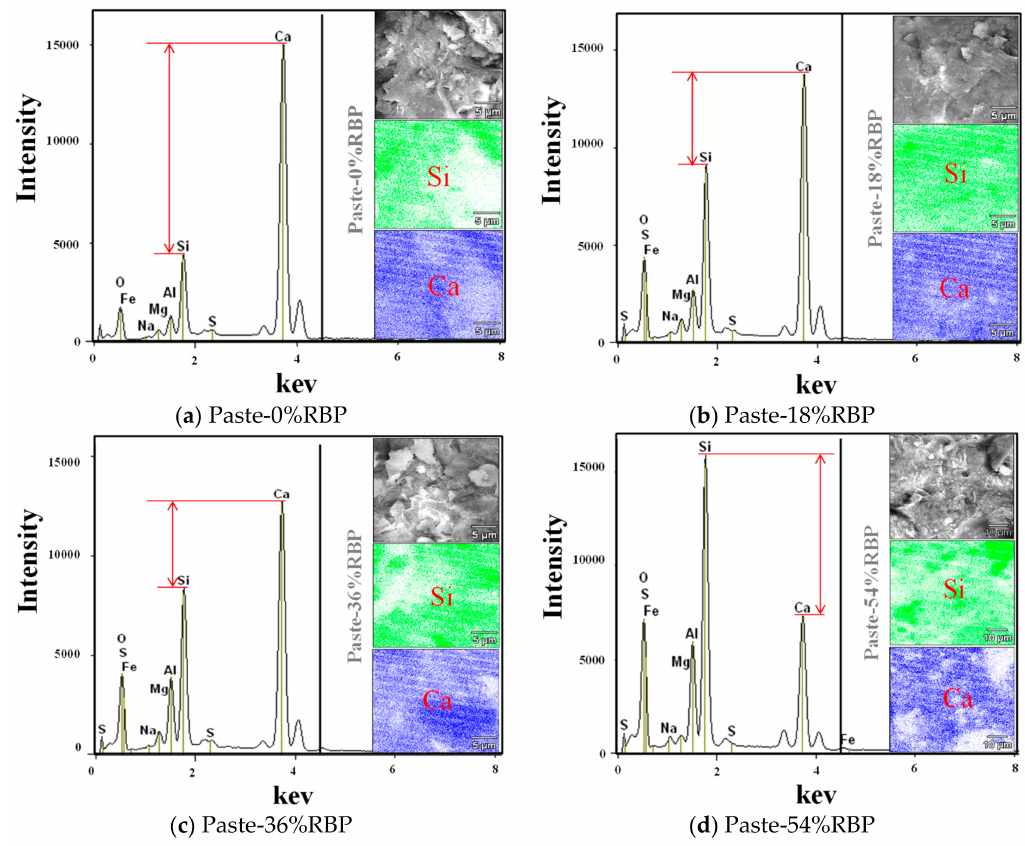
Figure 4. Elemental maps of the paste with various RBP replacements. ( a ) Paste-0%RBP; ( b ) Paste-18%RBP; ( c ) Paste-36%RBP; ( d )